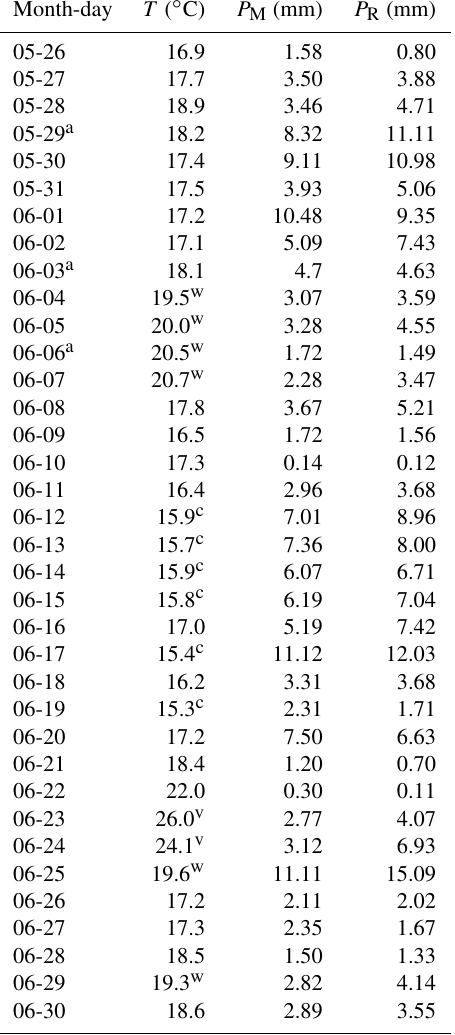
Table A1. Mean 2m temperature T and 10m wind speed v for each day, averaged over COSMO analysis data between 08:00 and 20:00UTC; daily precipitation sums P M from model output; and P R from RADOLAN. In the temperature column, footnotes show days classified as cool ( c ), warm ( w ), and very warm ( v ). The days marked with a are simulated for three